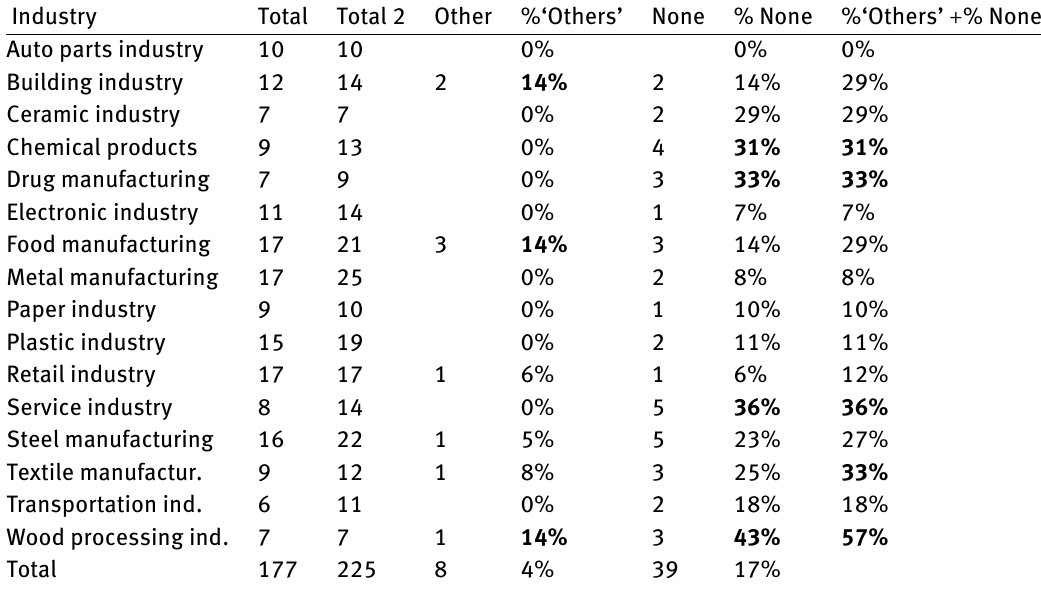
Table 4: Other options’ share according to industries. Industry